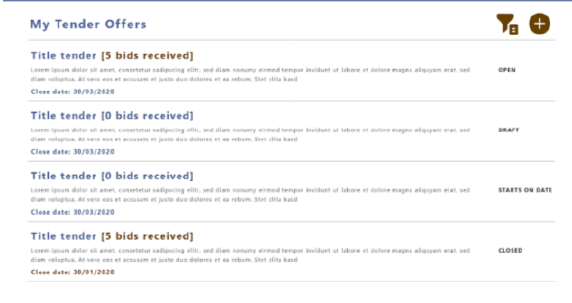
Figure A1. Tender Offer Manager SSApp - List of tender offers